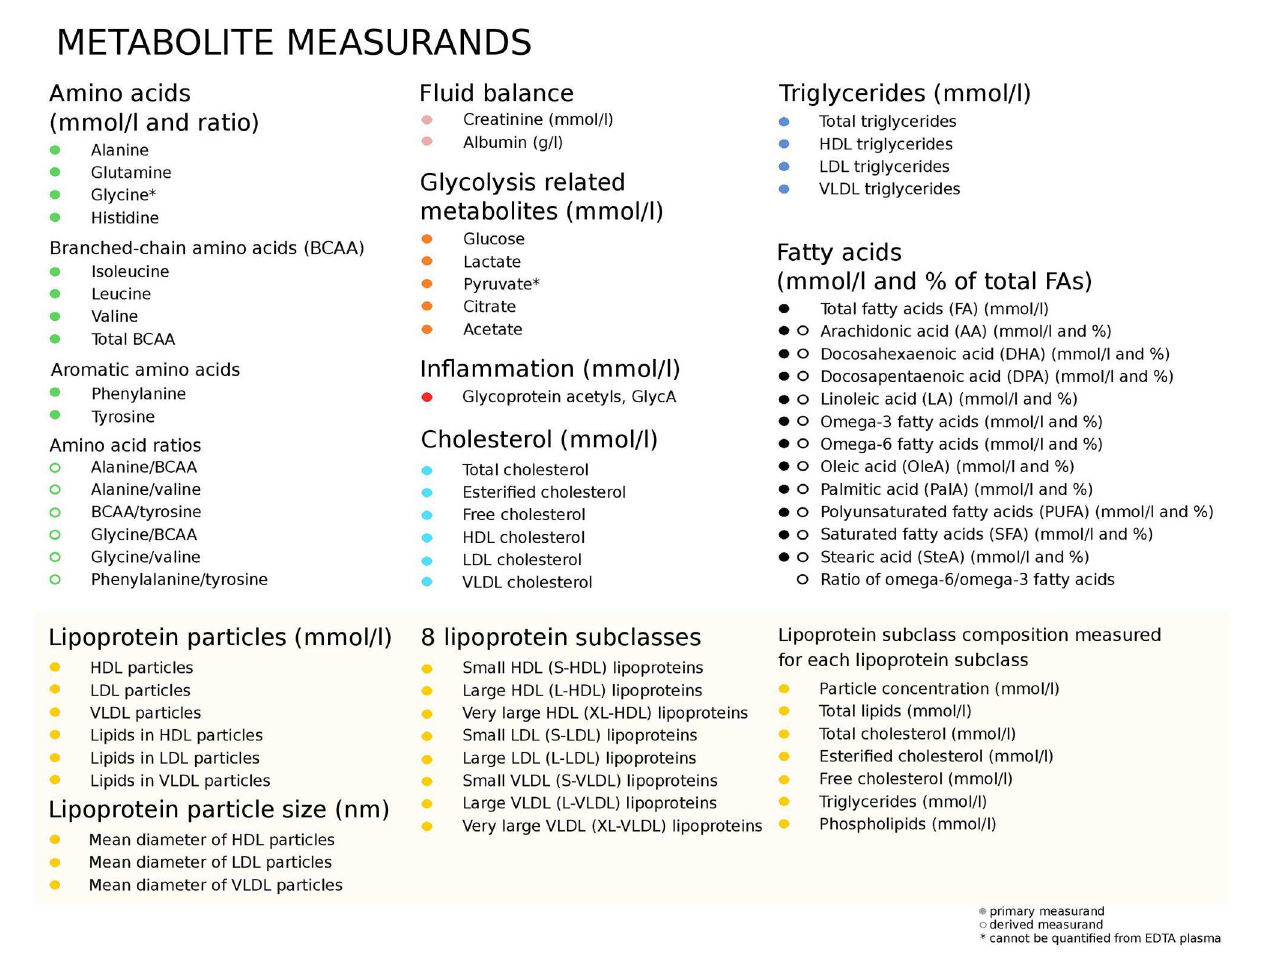
FIGURE1 Measurands quantified using the validated (24) canine NMR metabolomics platform. BCAA, Branched-chain amino acids; HDL, High-density lipoprotein; LDL, Low-density lipoprotein; VLDL, Very low-density